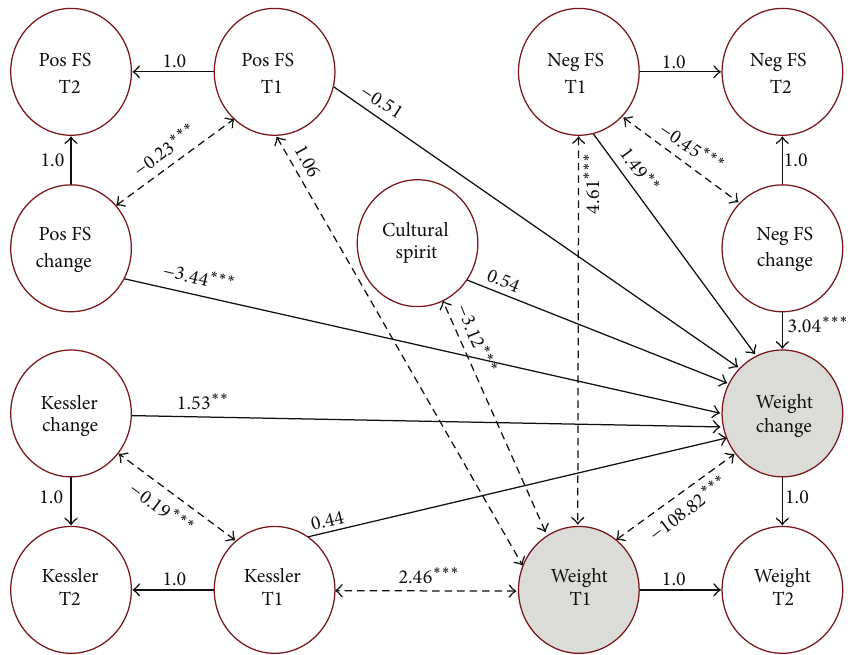
Figure 1: Final multivariate model results (unstandardized). Gender, age, education, and income were included in the model as covariates. Coping and trauma were dropped from the final model, because they were neither significant correlates of baseline weight nor significant predictors of change in weight. Double-headed arrows (dashed lines) represent correlations. Single-headed arrows (solid lines) represent regression paths. T1 = baseline; T2 = follow-up; Pos FS = positive family support; Neg FS = negative family support; cultural spirit = cultural spirituality. ∗∗ 𝑝 < .01 . ∗∗∗ 𝑝 < .001